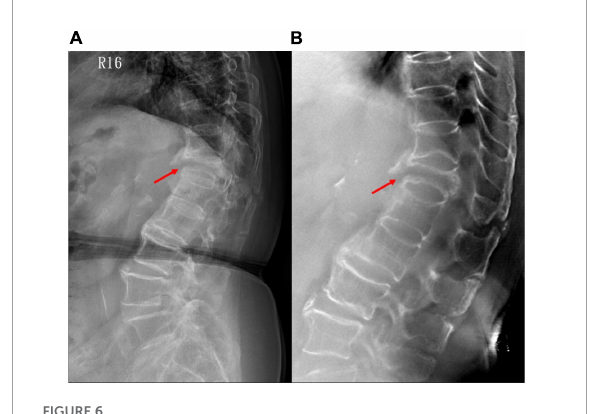
FIGURE6 A patient with non-union of VCF on the 3-month follow-up. (A) Plain radiograph shows non-union with a gap at the anterior vertebral edge (arrow); while (B) tomosynthesis more clearly demonstrates both anterior and posterior vertebral edge involvement. VCF, vertebral compression